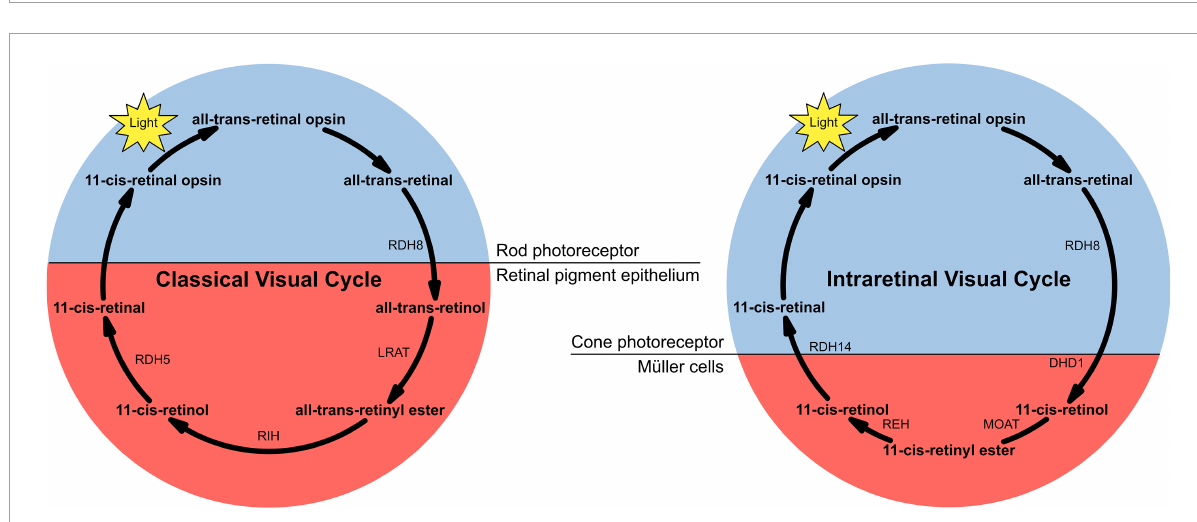
FIGURE2 The two versions of the visual cycle, classical and intraretinal, a series of chemical reactions, mostly enzyme-catalysed, underlying chromophore regeneration in rods and cones, respectively. Intra- and extra-photoreceptor processes are shaded blue and red, respectively. Rods work with the retinal pigmented epithelium in the classical visual cycle, whereas cones work with Müller cells in the intraretinal visual